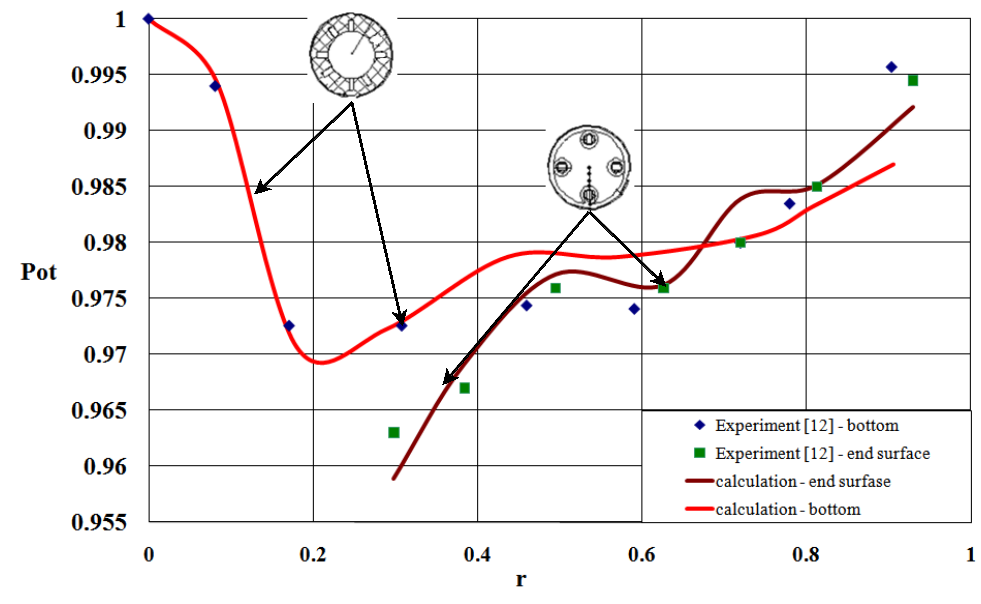
Figure 2. Relative pressure distribution over the nozzle bottom and end surface.